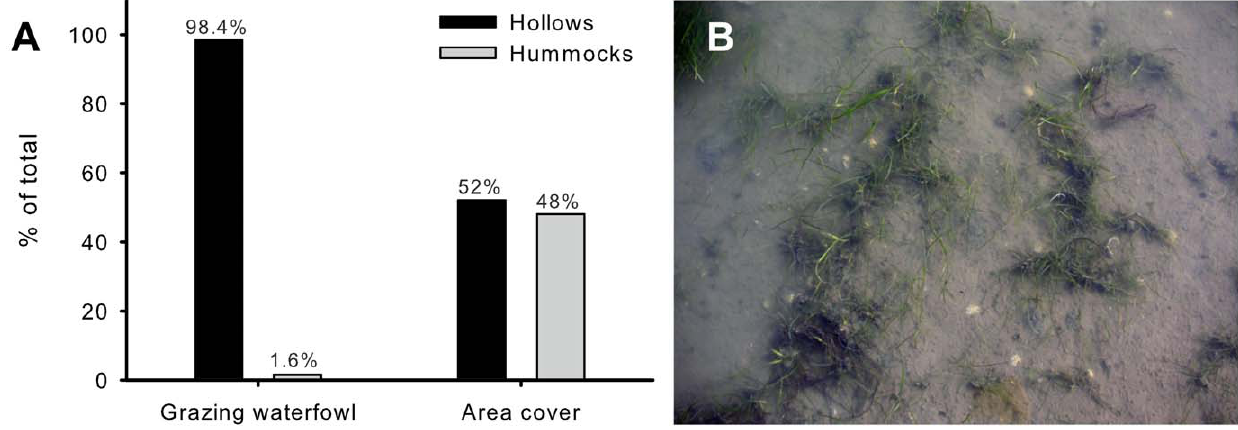
Figure 2. Over 98% of all grazing waterfowl was feeding in hollows (A), whereas hollows covered only 52% of the entire 1-hectare area ( x 2 =106.89, df=1, p , 0.001). Visual observations showed obvious grazing scars in the hollows (B): trampling and beak marks, uprooted plants, floating leaves, and a removal of seagrass up to 90% of the original biomass. Hummocks, in contrast, were minimally impacted.